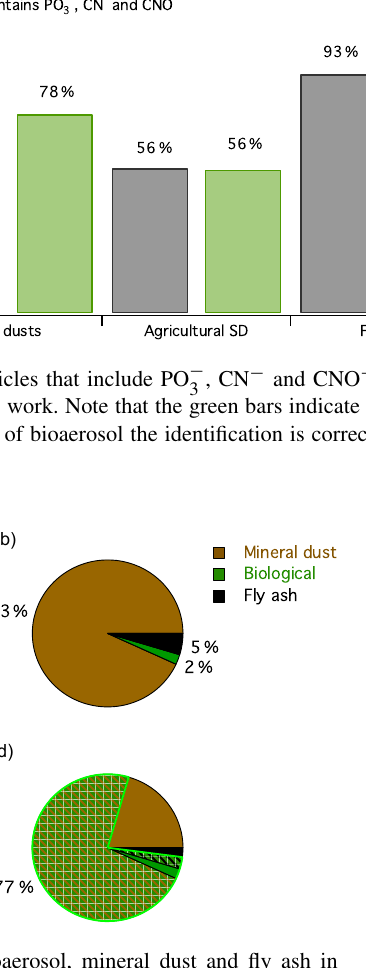
Figure 9. Abundance of bioaerosol, mineral dust and fly ash in the atmosphere constructed using emissions estimates in Table 3. (a) Highest estimate for bioaerosol coupled to lowest estimates for dust and fly ash. (b) Lowest estimate of bioaerosol in the atmo- sphere coupled to highest estimates for dust and fly ash. (c, d) Effect of misidentification of phosphate- and organic-nitrogen-containing aerosol as biological using the emissions in (a) and (b) , respectively. The hatched regions correspond to the misidentified fractions of mineral dust and fly ash. In these estimates the correct emissions (solid green region) in (a) and (b) (17 and 2%, respectively) are overestimated (hatched green region of misidentified aerosol plus solid green region) in (c) and (d) (as 81 and 77%,